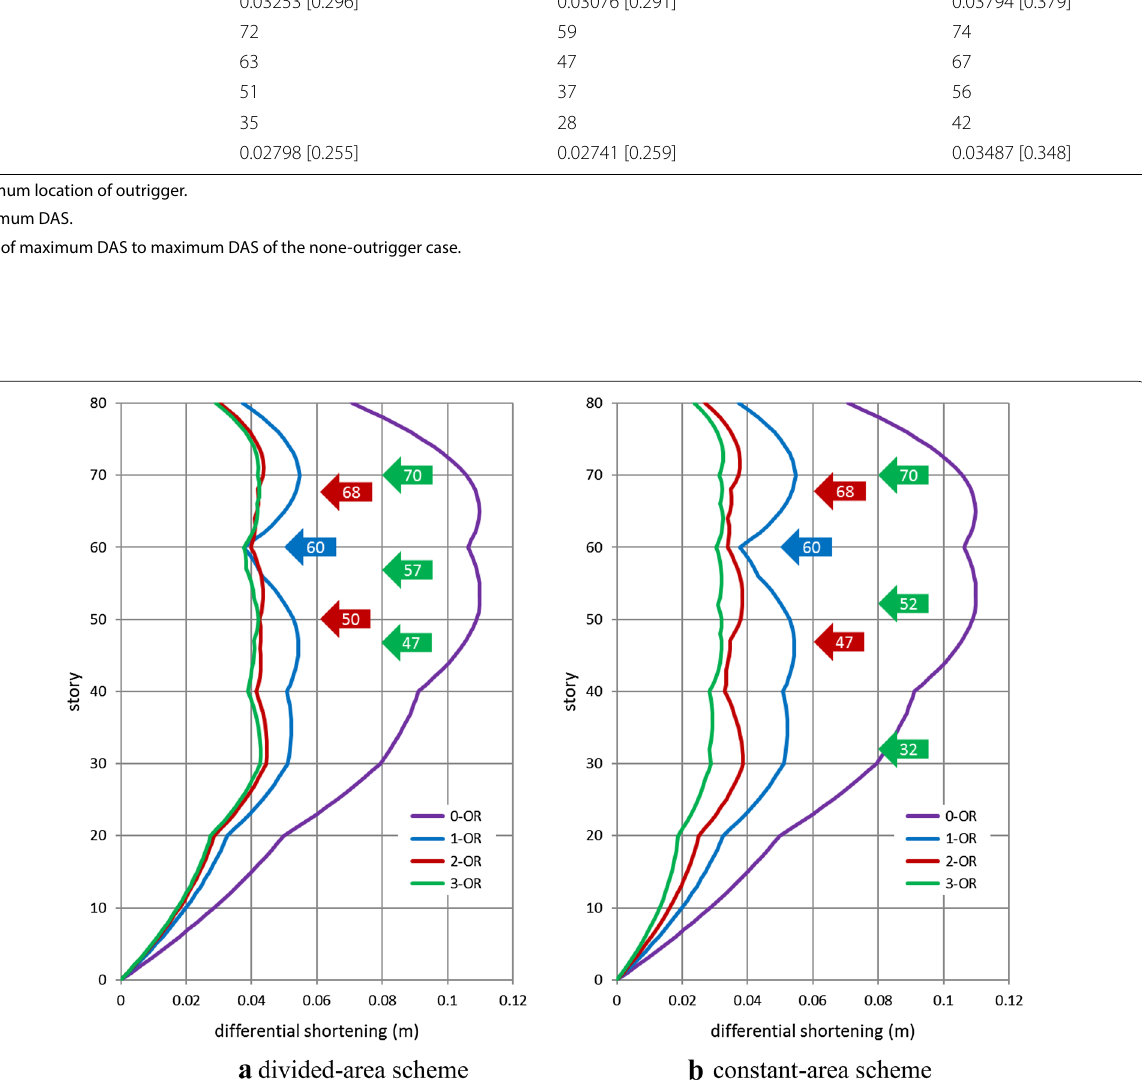
Fig. 7 Optimum locations and DAS for the general